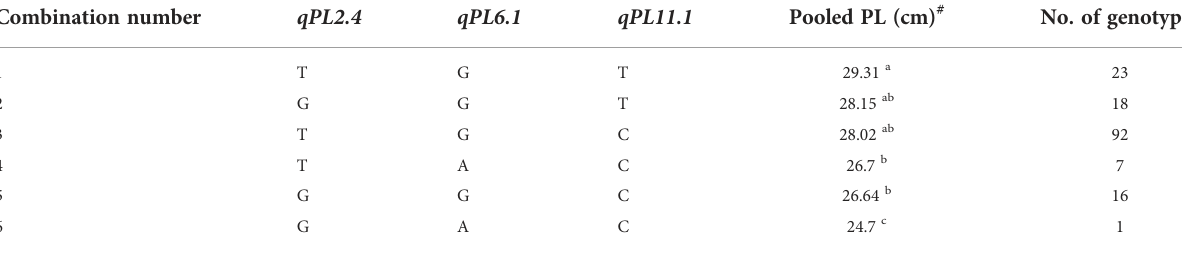
TABLE 10 List of all available homozygous allelic combinations of selected QTNs for PL.